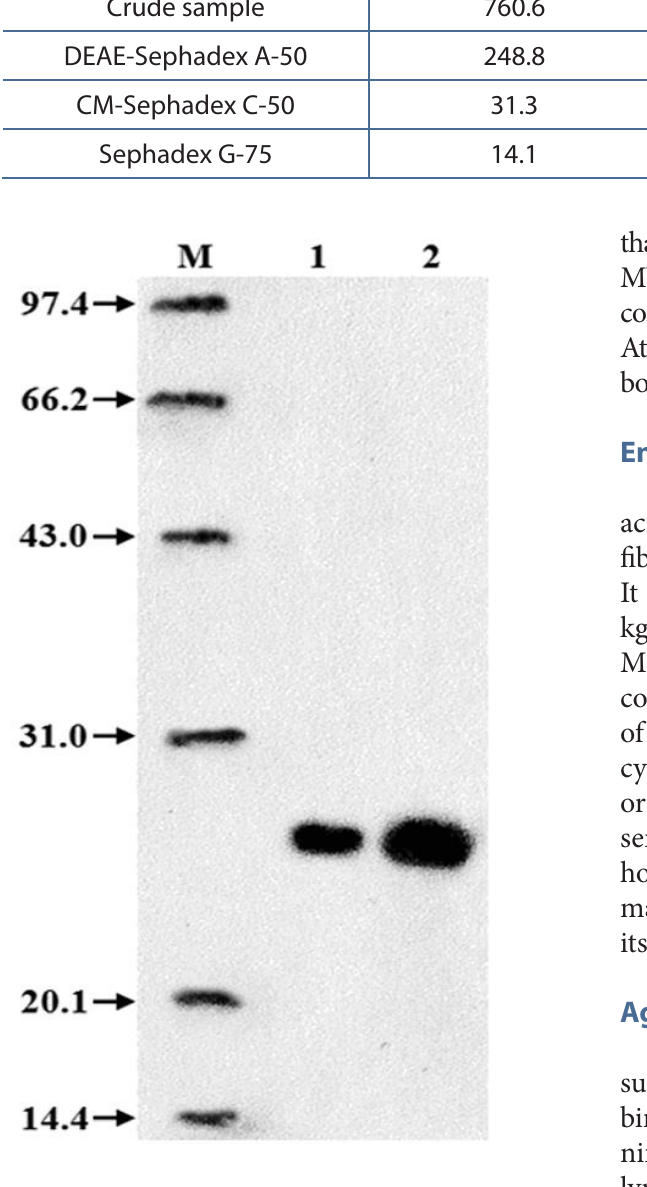
Figure 1. 12% SDS-PAGE of acutolysin C from A. acutus venom. Lane 1: under non-reducing conditions; lane 2: under reducing conditions with β-mercaptoethanol; lane M: protein weight marker (rabbit phosphorylase b,97.4; bovine serum albumin, 66.2; rabbit action ovabumin, 43.0; bovine carbonic anhydrase, 31.0; trypsin inhibitor, 20.1; hen egg white lysozyme, 14.4). The positions of protein size markers (kDa) are shown on the